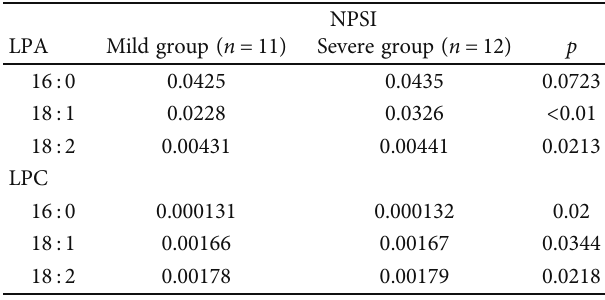
Table 1: RNA primer sequences. Gene RNA primer sequences